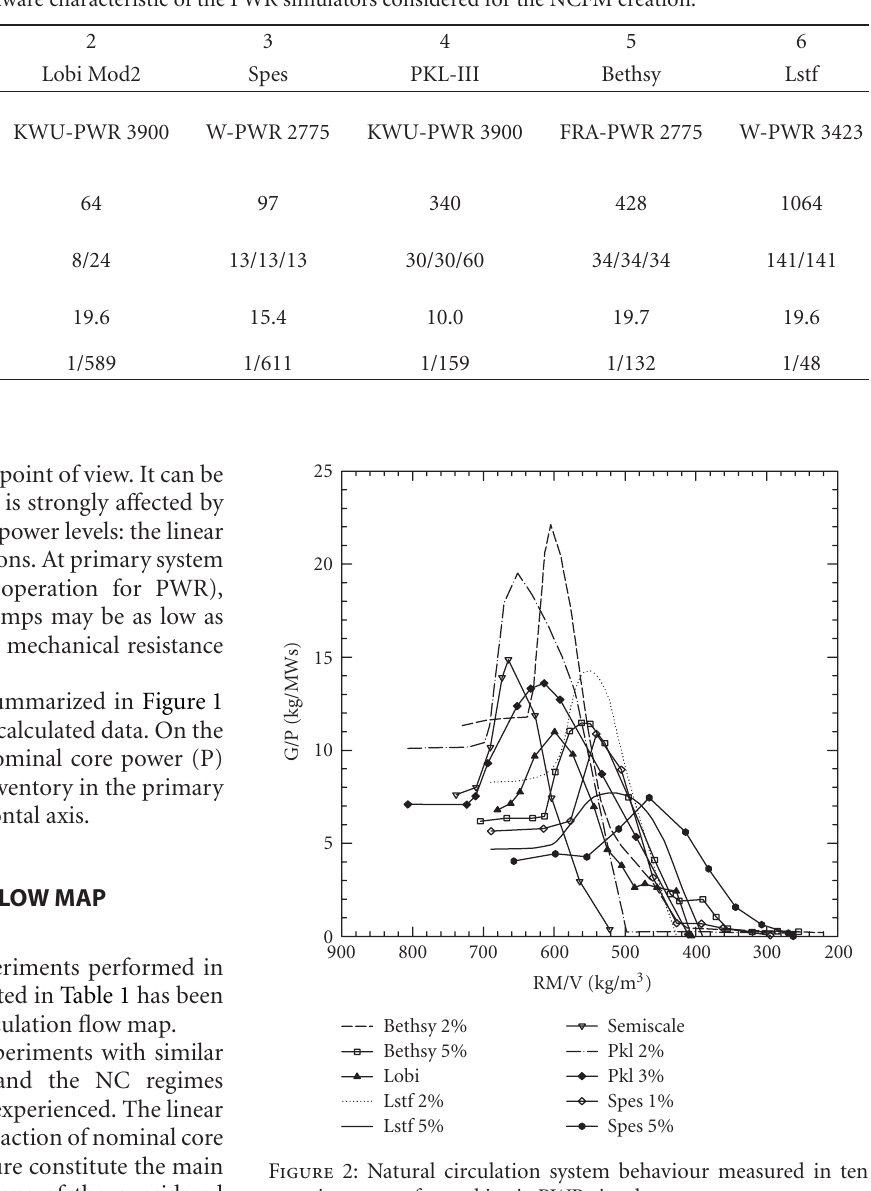
Table 1: Relevant hardware characteristic of the PWR simulators considered for the NCFM creation.